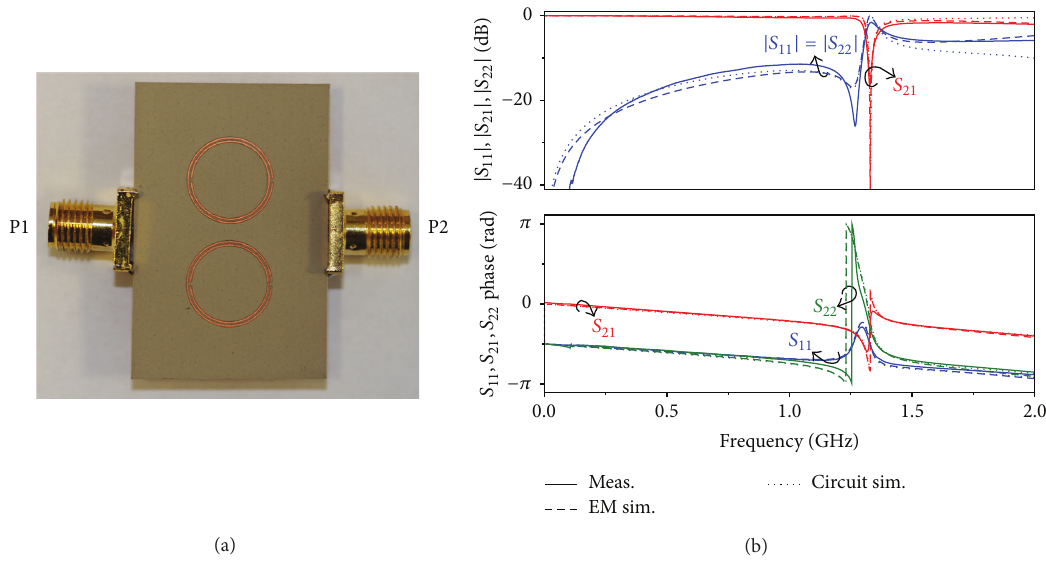
Figure 13: Bottom side photograph of the fabricated SRR-loaded CPW with 𝜙 = 90 ∘ (a) and frequency response (b). Dimensions are 𝑊 = = 5 mm, and 𝑐 = 𝑑 = 0.2 mm. The extracted circuit parameters are 𝐿 = 1.5 nH, 𝐶 = 6.1 pF, 10.4 mm, 𝐺 = 1.6 mm, external radius 𝑟 ext = 28.2 nH, 𝐶 = 0.43 pF, 𝑀 = 1.35 nH, and 𝐶 = 0.08 pF. From [46], reprinted with permission. 𝐿 𝑠 𝑠 𝑎